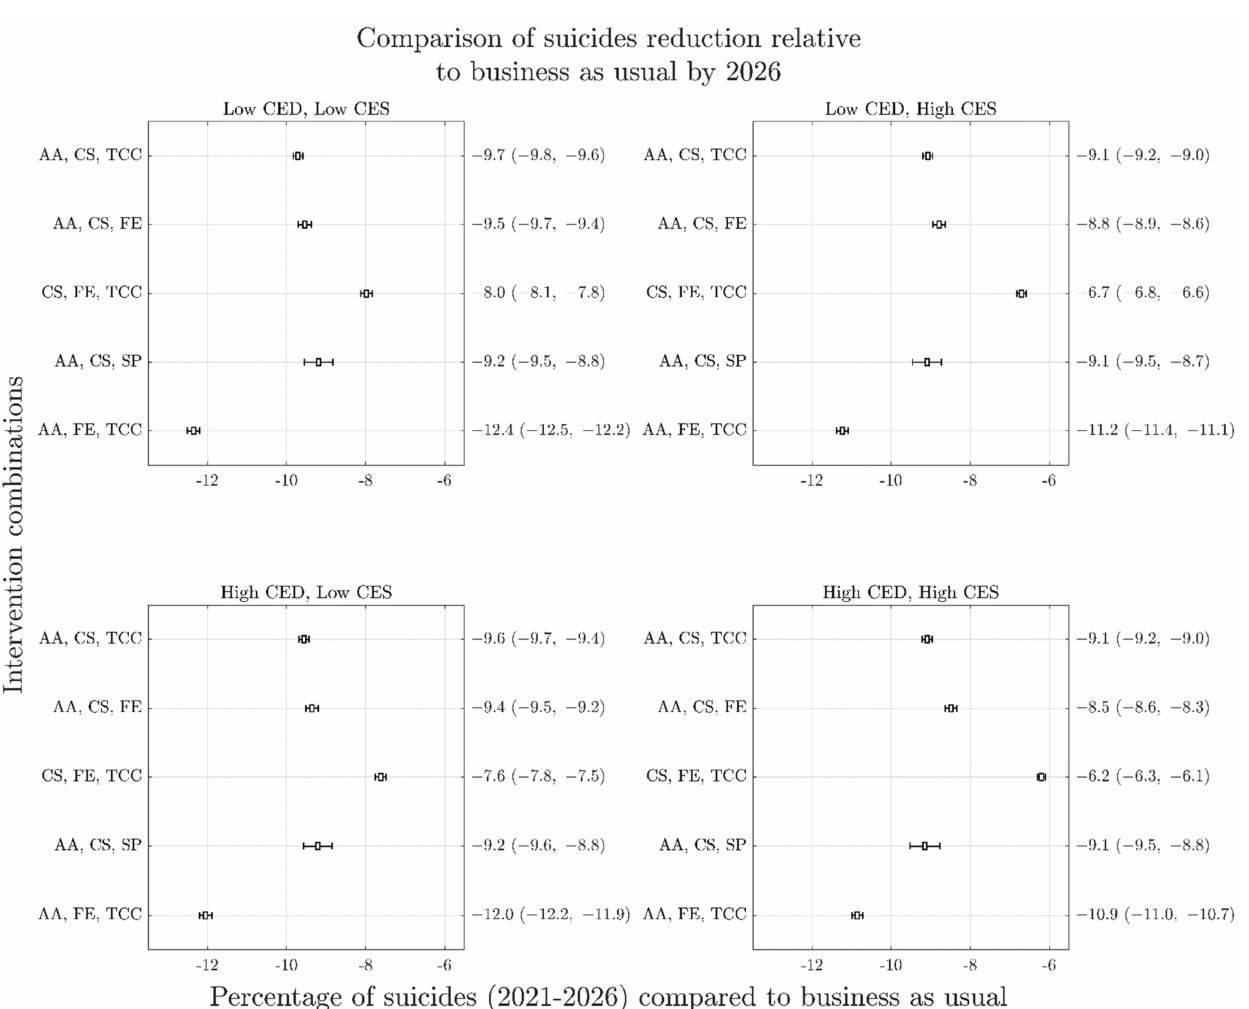
Figure 5. Forest plots similar to Figure 3 for percent reduction in cumulative suicides over the period 2021–2026 as a result of top performing intervention combinations. Note substantially different per- formance rankings from Figure 3 but similarity of rankings across COVID-19 mental health scenarios. Panels represent different COVID-19 scenarios (A–D) as per previous figures. AA is post-suicide attempt aftercare; CS is community support programs to increase community connectedness; SP is safety planning; FE is family education and support; TCC is technology-enabled care